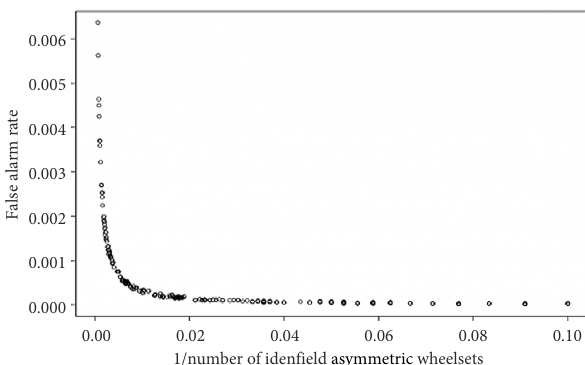
Figure 5. Pareto frontier for identified asymmetric